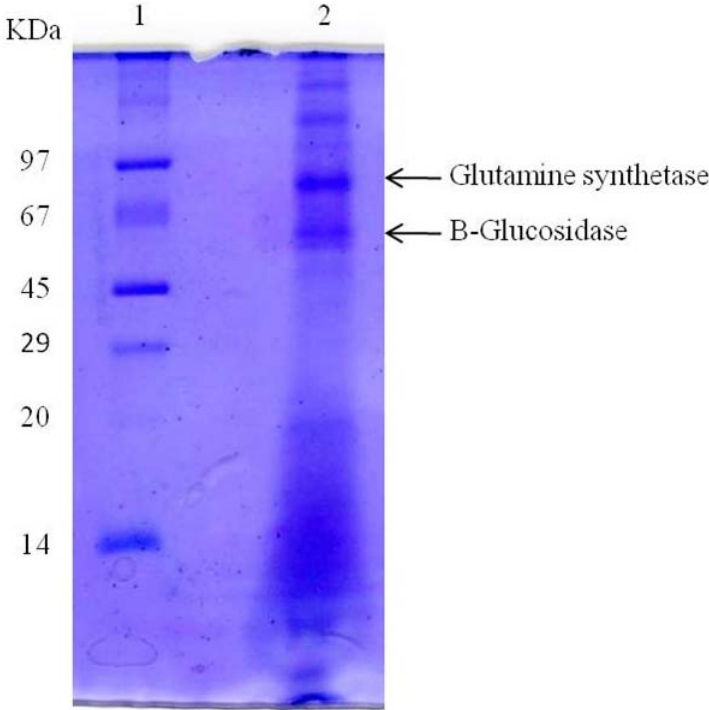
Figure 1. SDS-PAGE—In house antigen (34 μ g) were loaded on a 15% polyacrylamide gel and resolved with a constant current of 20 mA for approximately 2 h. Protein bands were stained with Coomassie Blue R250. Lane 1, molecular mass markers (Phosphorylase